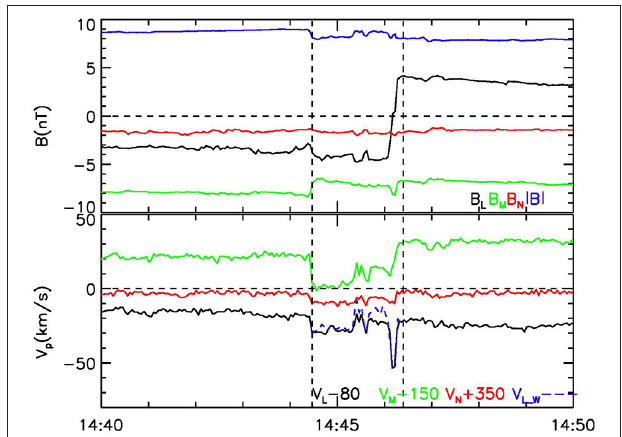
FIGURE 3 | Magnetic field and velocity curves measured in LMN coordinate system of the reconnection exhaust around 14:45 UT November 16th, and the blue dashed curve presents the V L velocity derived from the Walén relation. The two vertical dashed lines denote the reconnection exhaust